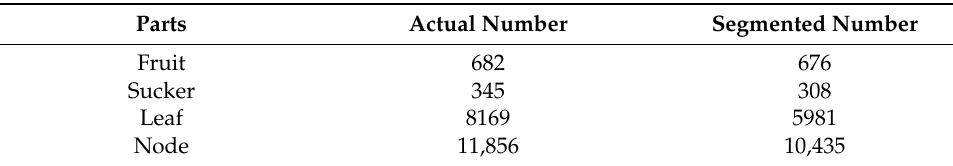
Table 4. Numbers of parts retained after image